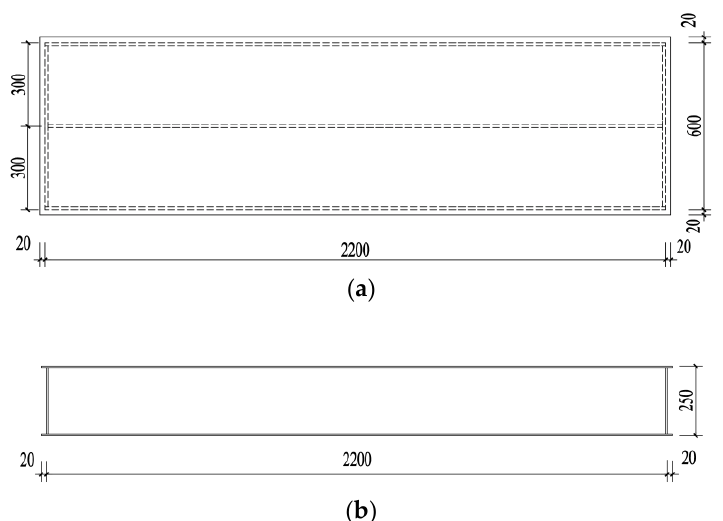
Figure 1. Overall dimensions of concrete-filled steel box slabs: ( a ) Plan; ( b ) Elevation.